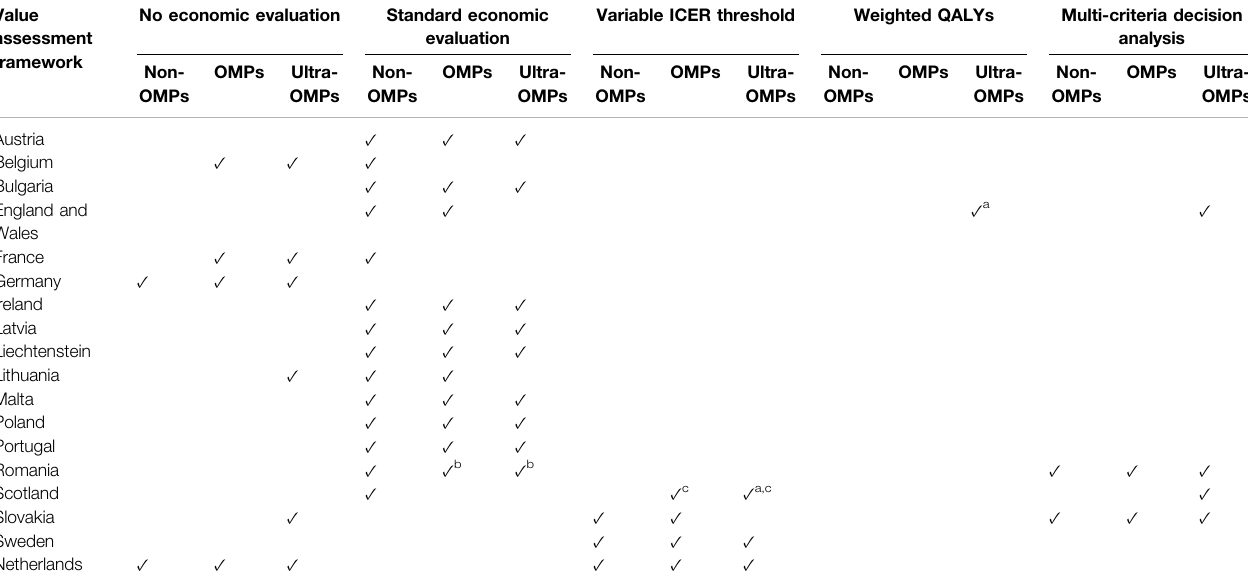
TABLE 4 | An overview of the combinations of value assessment frameworks that are applied for non-OMPs, OMPs and ultra-OMPs across geographical Europe. Value